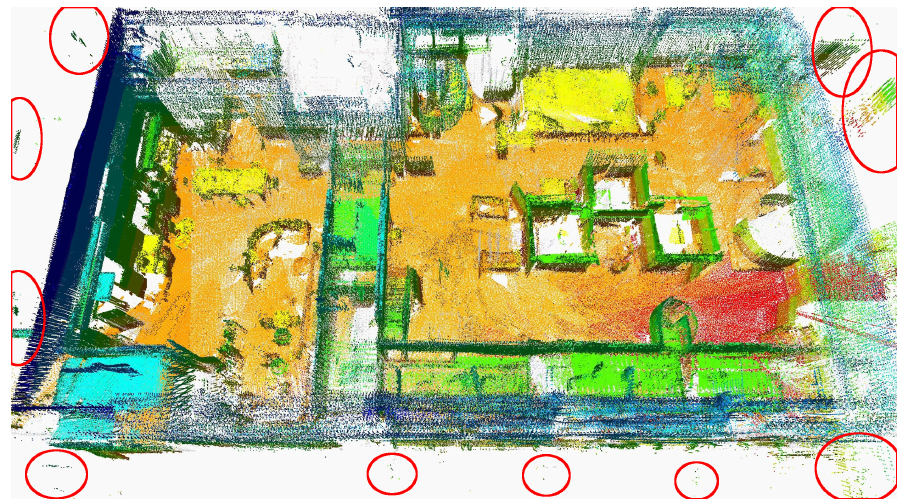
Figure 18. Startup Sauna test site, point cloud visualization. The registered Würzburg backpack and TLS point clouds are shown. Coloring is based on height. An abundance of outliers (marked with red circles for visualization purposes) that is present outside of the image is only partly shown.